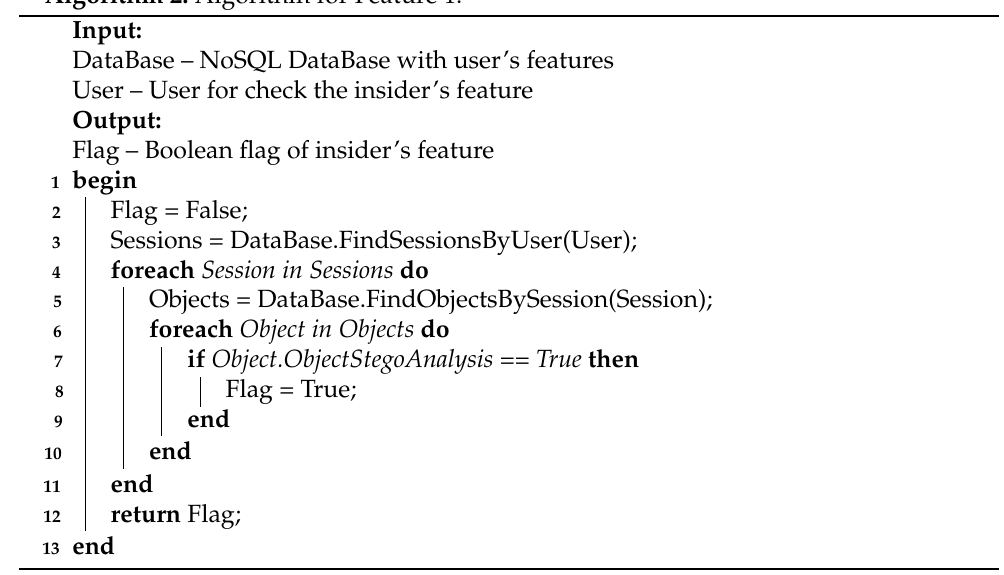
Algorithm 2: Algorithm for Feature